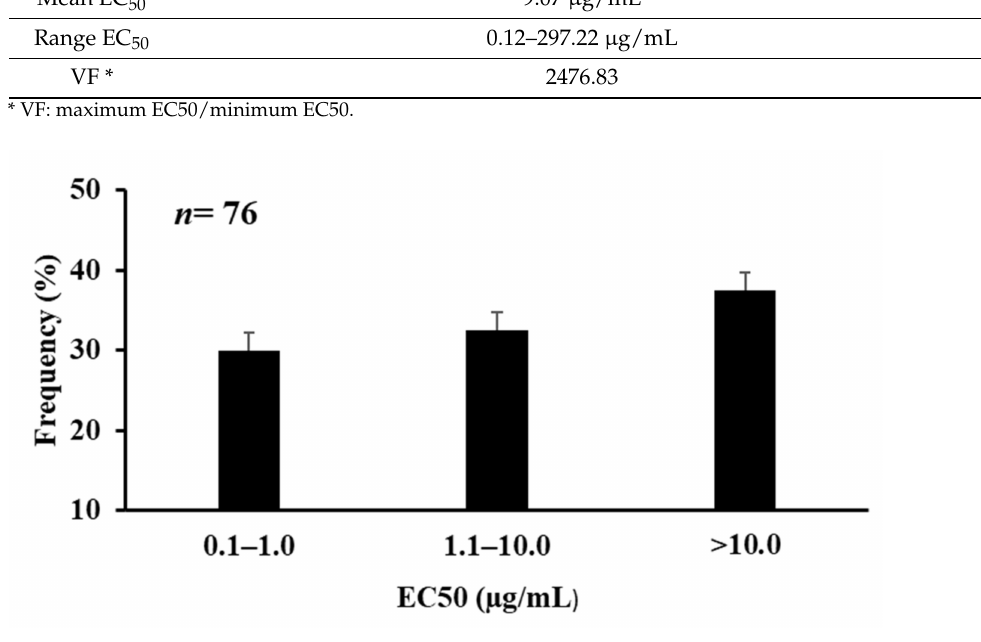
Figure 2. Frequency distribution of EC 50 values ( µ g/mL) for azoxystrobin of A. flavus isolates ( n = 76) from multiple five seed lots in